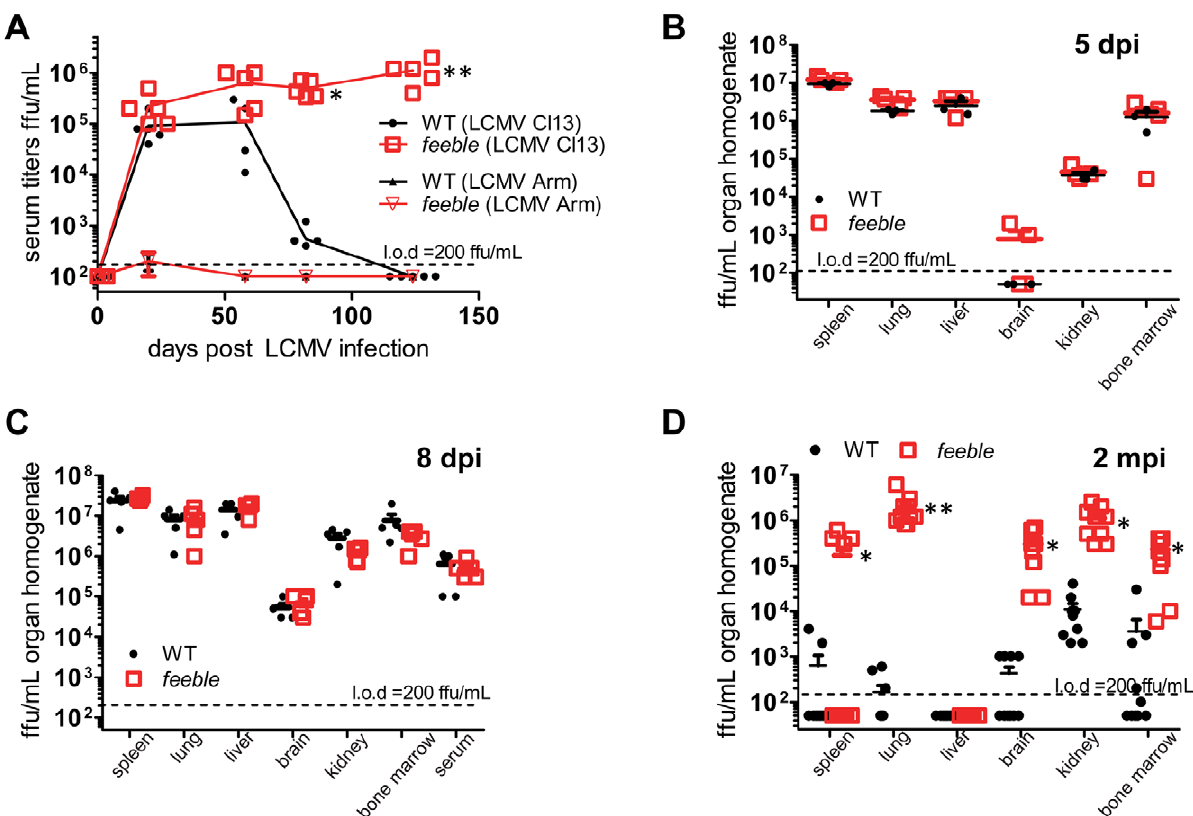
Figure 1. Slc15a4 is required to control chronic viral infection. Serum and organs were collected at the indicated times post LCMV infection and infectious virus was titered. WT and feeble mice were infected i.v. with 2 6 10 6 pfu of the acute LCMV Armstrong (Arm) strain or the persistent LCMV Clone 13 (Cl13) strain (A). Serum was then harvested at the indicated time points for . 4 months to enumerate viremia. After Cl13 infection, organs were harvested from WT and feeble mice 5 dpi (B), 8 dpi (C), and 2 mpi (D), homogenized and titered for infectious virus. Individual replicates and means are shown. Feeble , Slc15a4 feeble/feeble mice; l.o.d., limit of detection. Representative data of 2 independent experiments are shown; n . =5 per group. Unless marked, p . 0.05 between WT and feeble and not statistically significantly